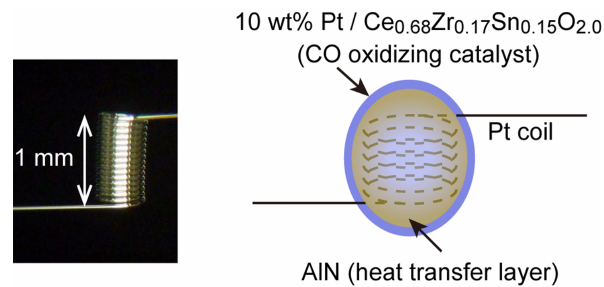
Figure 1. Photograph of the Pt coil employed in this work and an il- lustration of the catalytic combustion-type CO sensor incorporating an AlN interlayer and the 10wt% Pt loaded Ce 0 . 68 Zr 0 . 17 Sn 0 . 15 O 2 . 0 catalyst. Ce 0 . 68 Zr 0 . 17 Sn 0 . 15 O 2 . 0